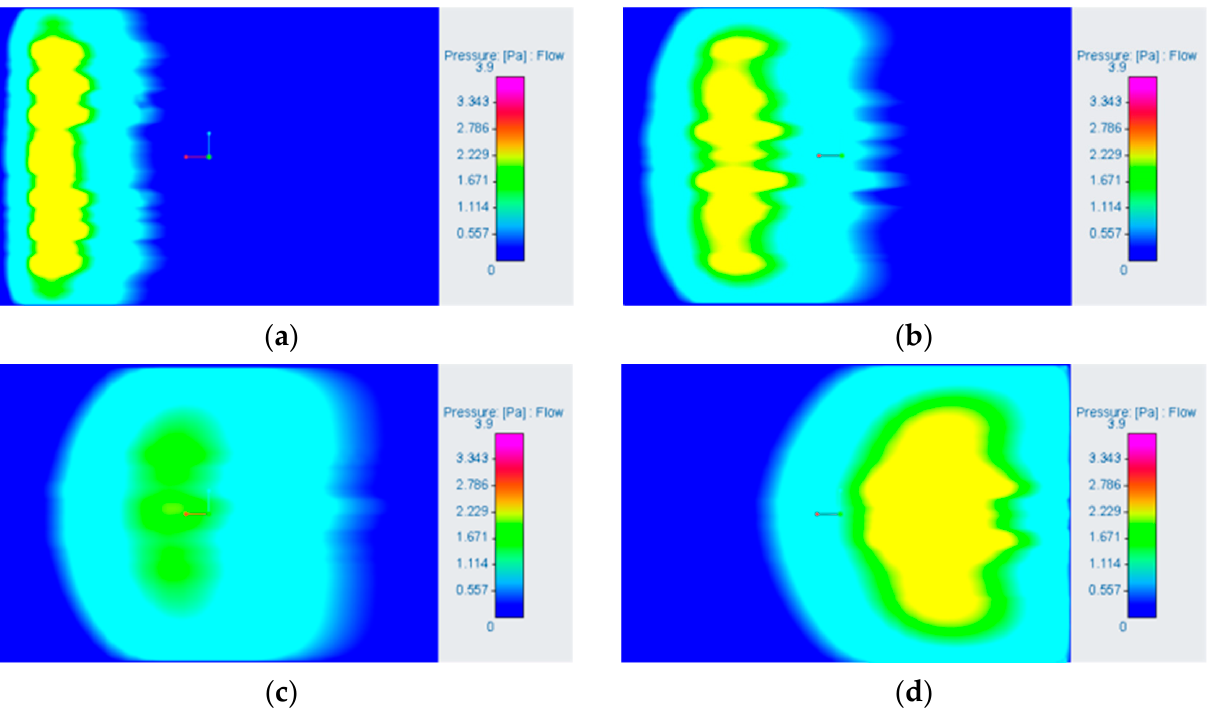
Figure 11. Pressure distribution diagram of all pipes in each row after the air outlet: ( a ) the second row of horizontal pipes; ( b ) the third row of horizontal pipes; ( c ) the fourth row of horizontal pipes; ( d ) the fifth row of horizontal pipes.